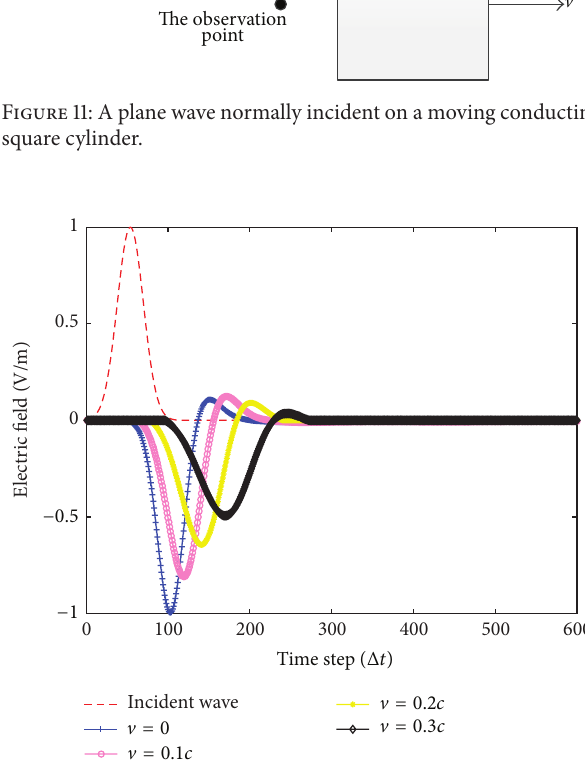
Figure 12: The time-domain scattered waveforms of the moving conducting square cylinder excited by the Gaussian